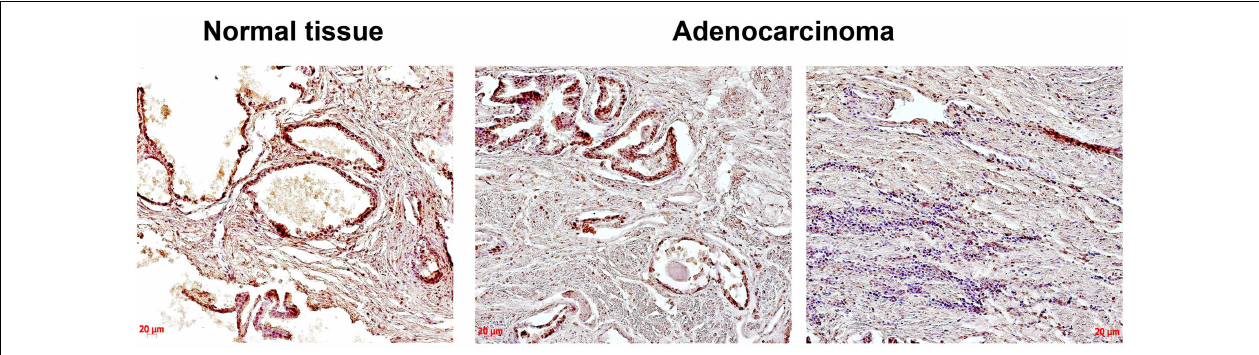
tumor show a heterogeneity of HS expression (high and low HS expression in morphologically different epithelial prostate cancer cells are shown on the left and right images, respectively), low HS expression in extracellular matrix is shown (light brown); representative prostate cancer specimen is presented; magnification ×